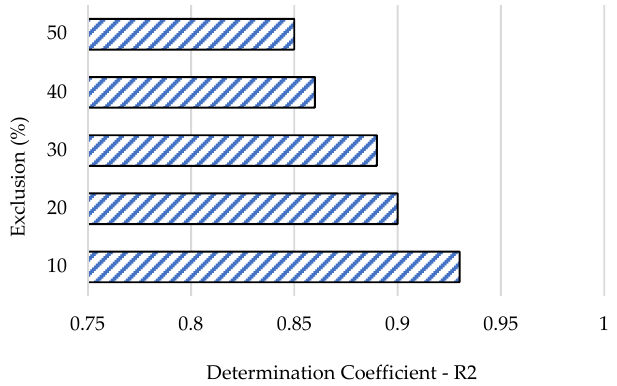
Figure 13. Coefficient of determination data from 10 to 50% samples exclusion.